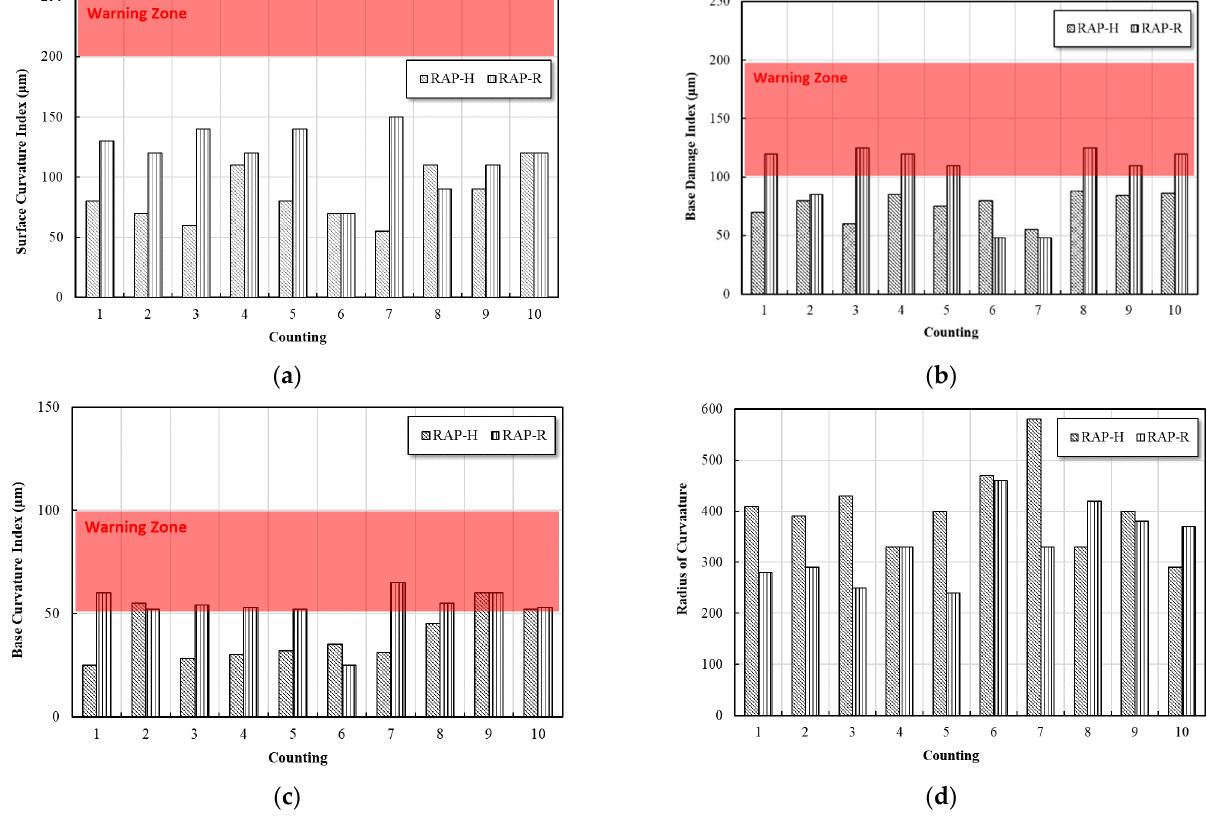
Figure 16. Layer index analysis: ( a ) SCI, ( b ) BDI, ( c ) BCI, ( d )